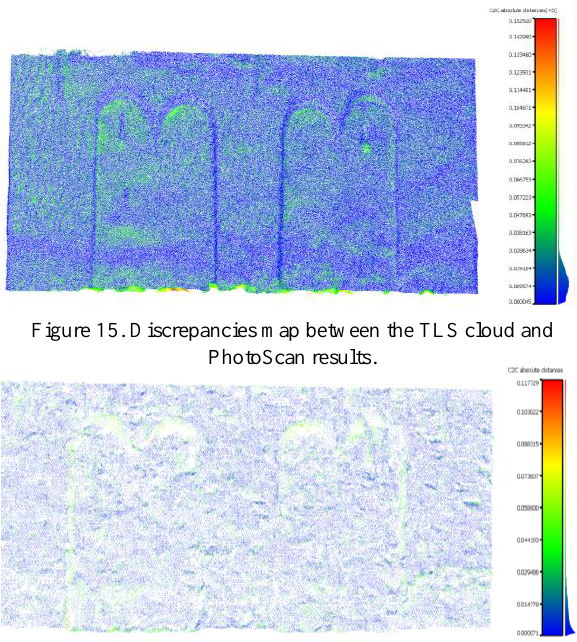
Figure 10. Discrepancies map between the TLS cloud and Context Capture results. Figure 14. Discrepancies map between the TLS cloud and 3D Zephir results. Although the statistical parameters about the measurements are quite similar to the other clouds, it is apparent how the density of the final point cloud is lower.